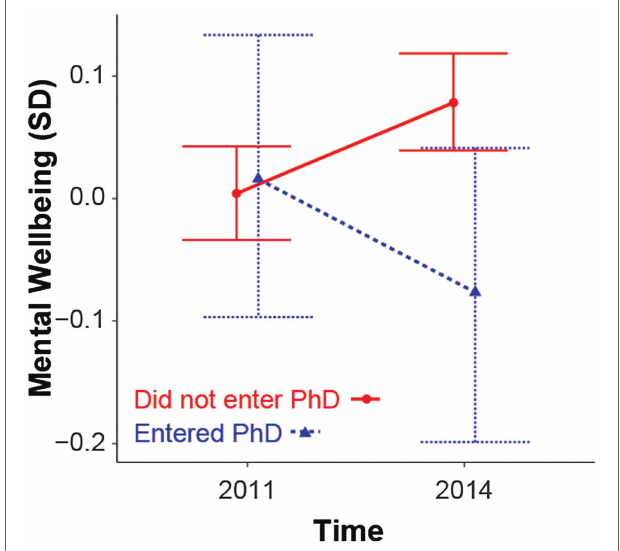
FIGURE 1 | Marginal effects on standardised and centred mental wellbeing in 2011 and 2014 for those who did and did not transitioned into PhD study. Error bars are 95% credible intervals.